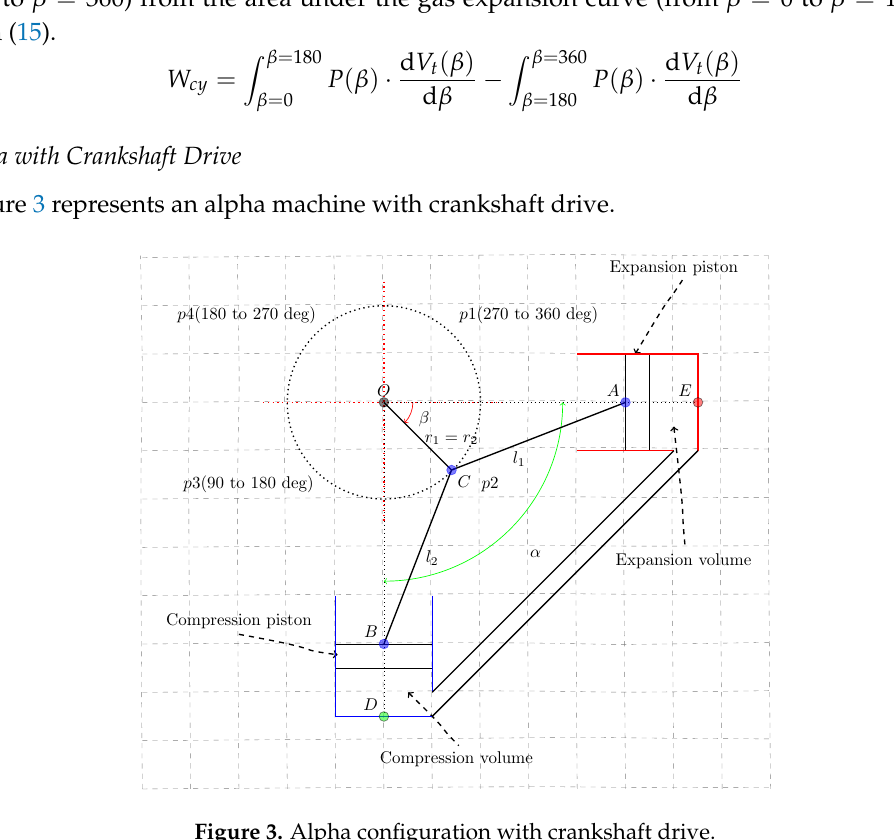
Figure 3. Alpha configuration with crankshaft